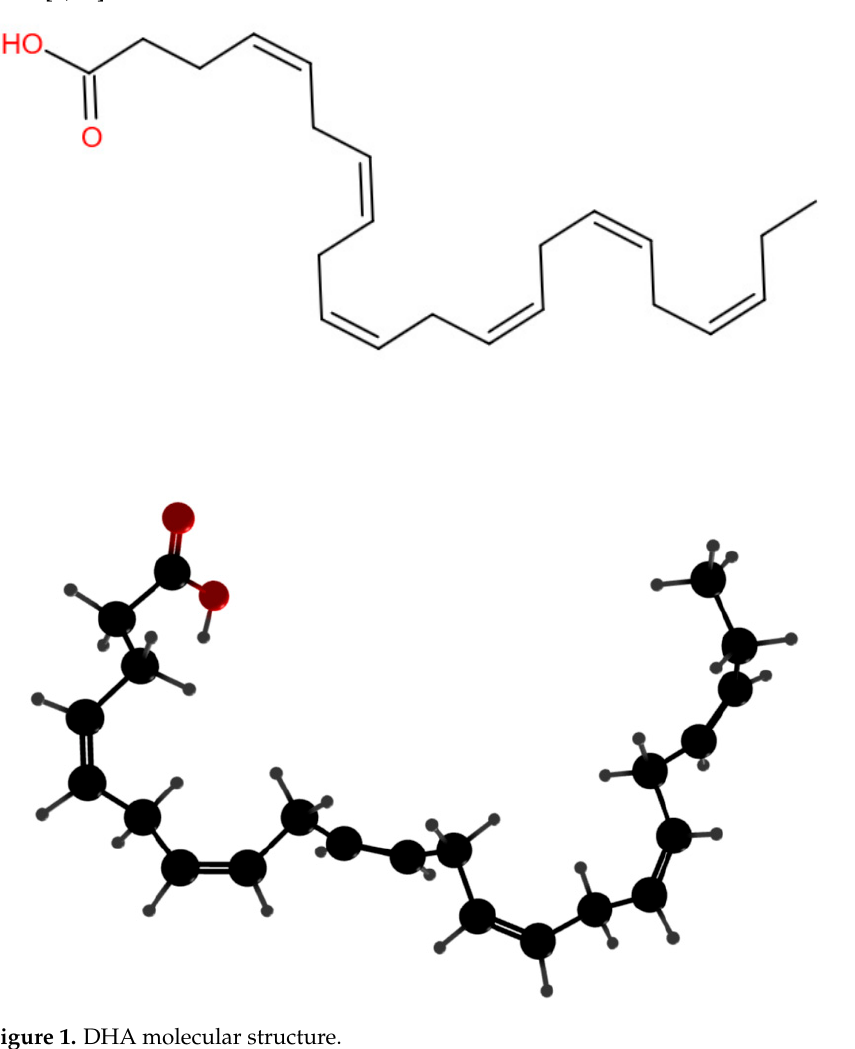
Figure 1. DHA molecular structure.